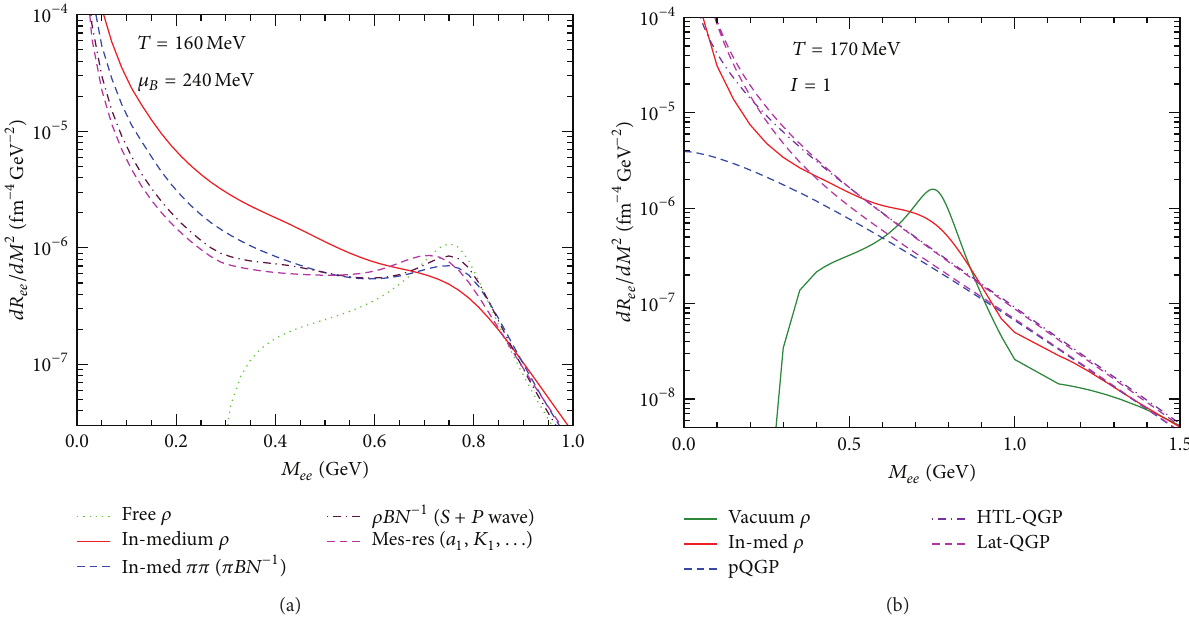
Figure 2: Dilepton rates from hot QCD matter in the isovector ( 𝜌 ) channel. (a) Effective hadronic Lagrangian plus many-body approach for the in-medium 𝜌 spectral function (solid line) at a temperature and chemical potential characteristic for chemical freezeout at full SPS energy; the effects of in-medium pion-cloud (long-dashed line), baryon resonances (dash-dotted line), and meson resonances (short-dashed line) are shown separately along with the rate based on the vacuum spectral function (dotted line). (b) Comparison of free and in-medium hadronic and partonic calculations at temperature 𝑇 = 170 MeV and small baryon chemical potential characteristic for RHIC and LHC conditions; the free and in-medium hadronic rates are based on [35, 36]; the “lat-QGP” rates (2 short-dashed lines) are based on fits to the 𝑞 = 0 lQCD rate with extensions to finite 3-momentum utilizing perturbative photon rates (see Section 2.2 for